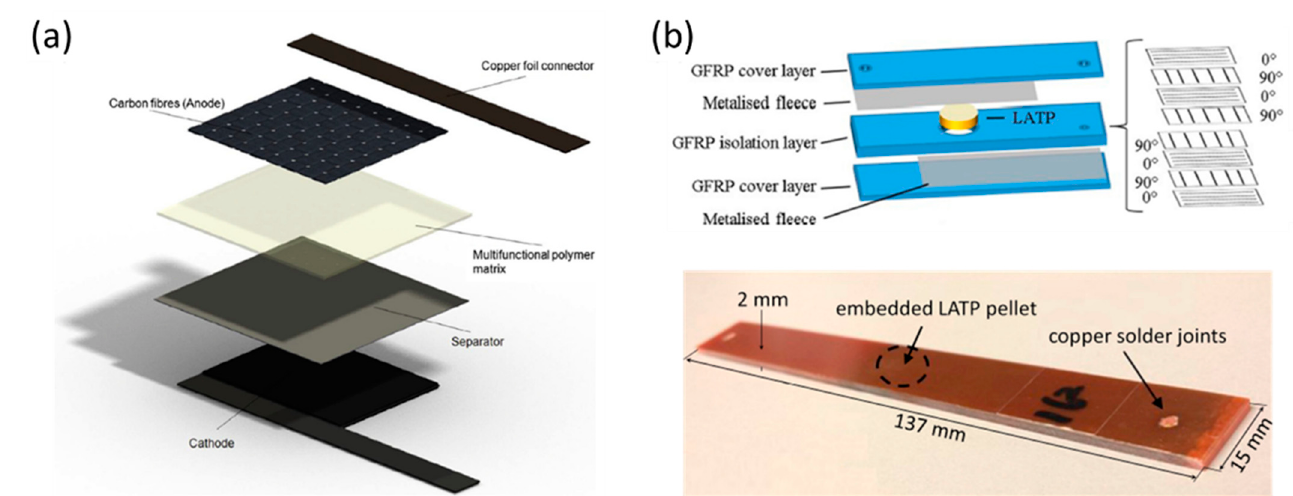
Figure 9. Representation of 2D ‐ woven composite material: 2 × 2 twill architecture for the anode and cathode [71] ( a ), and laminate unidirectional glass fiber plies with an embedded LATP (solid ‐ state electrolyte) pellet, adapted from [7] ( b ).